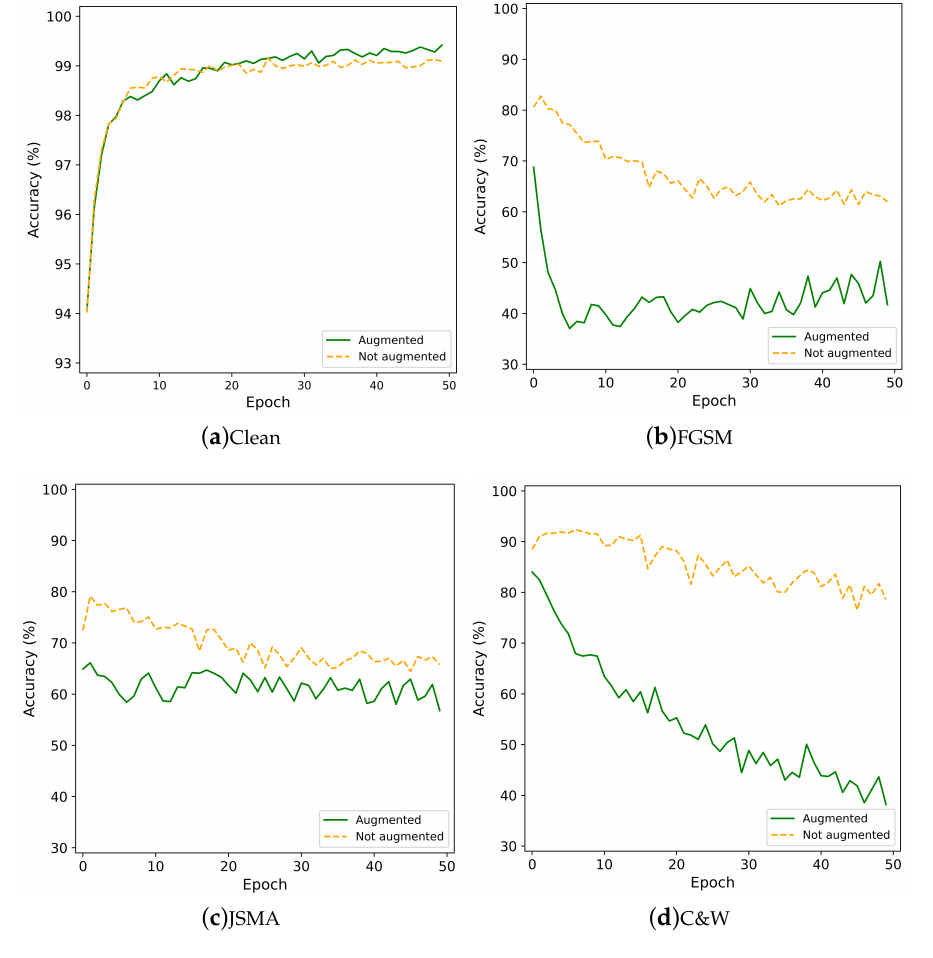
Figure 4. Test accuracy of LeNet5 model on each adversarial example attack. Each model is trained with: ( a ) Clean; ( b ) FGSM; ( c ) JSMA; and ( d )